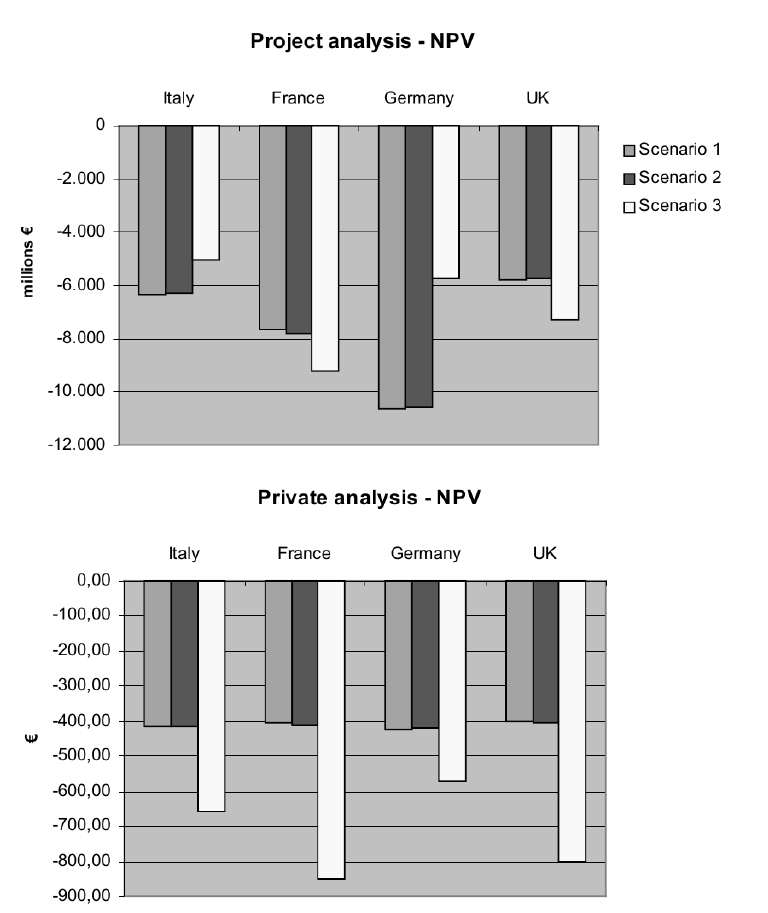
Figure 14. Cost-benefit analysis (CBA)